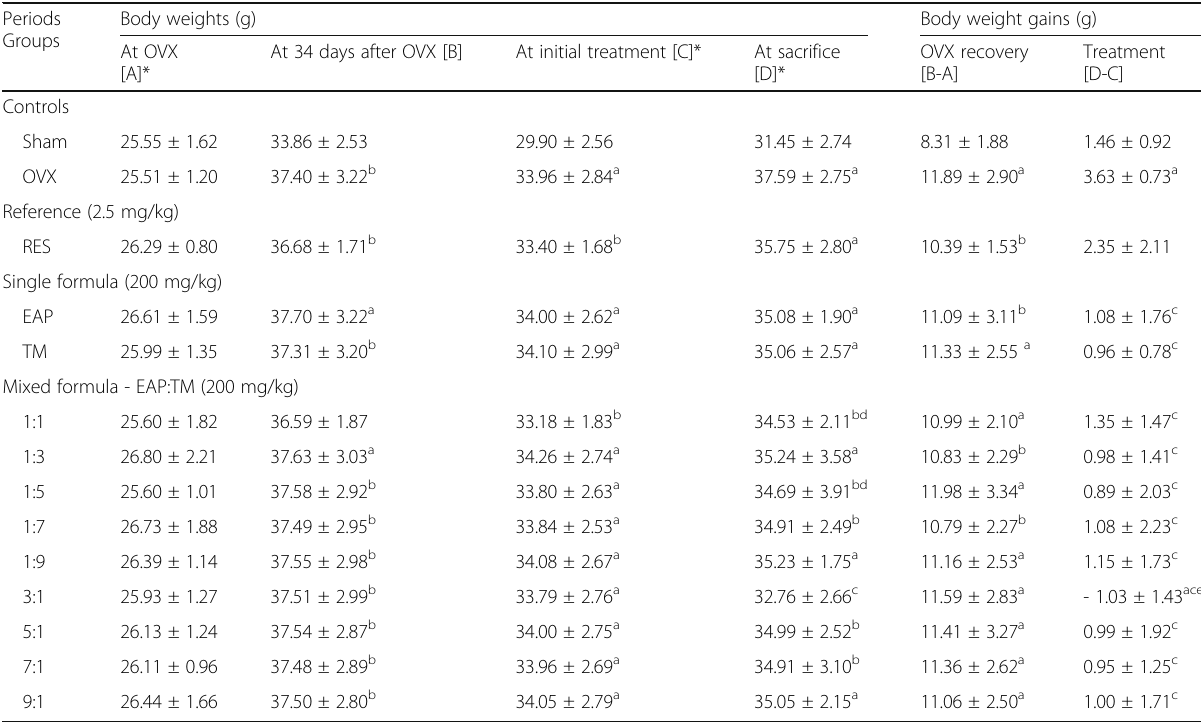
Table 1 Body weight gain in sham-operated and OVX